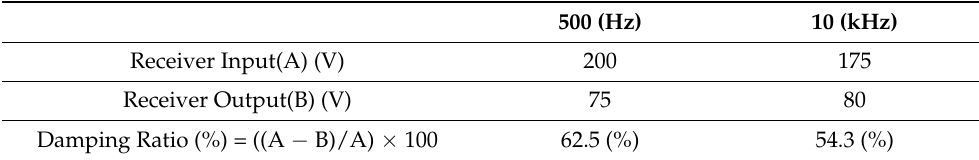
Figure 32. Expansion of Figure 31: ( a ) 1 kHz region; ( b ) 2 kHz region. Table 4. Comparison of the response characteristics to